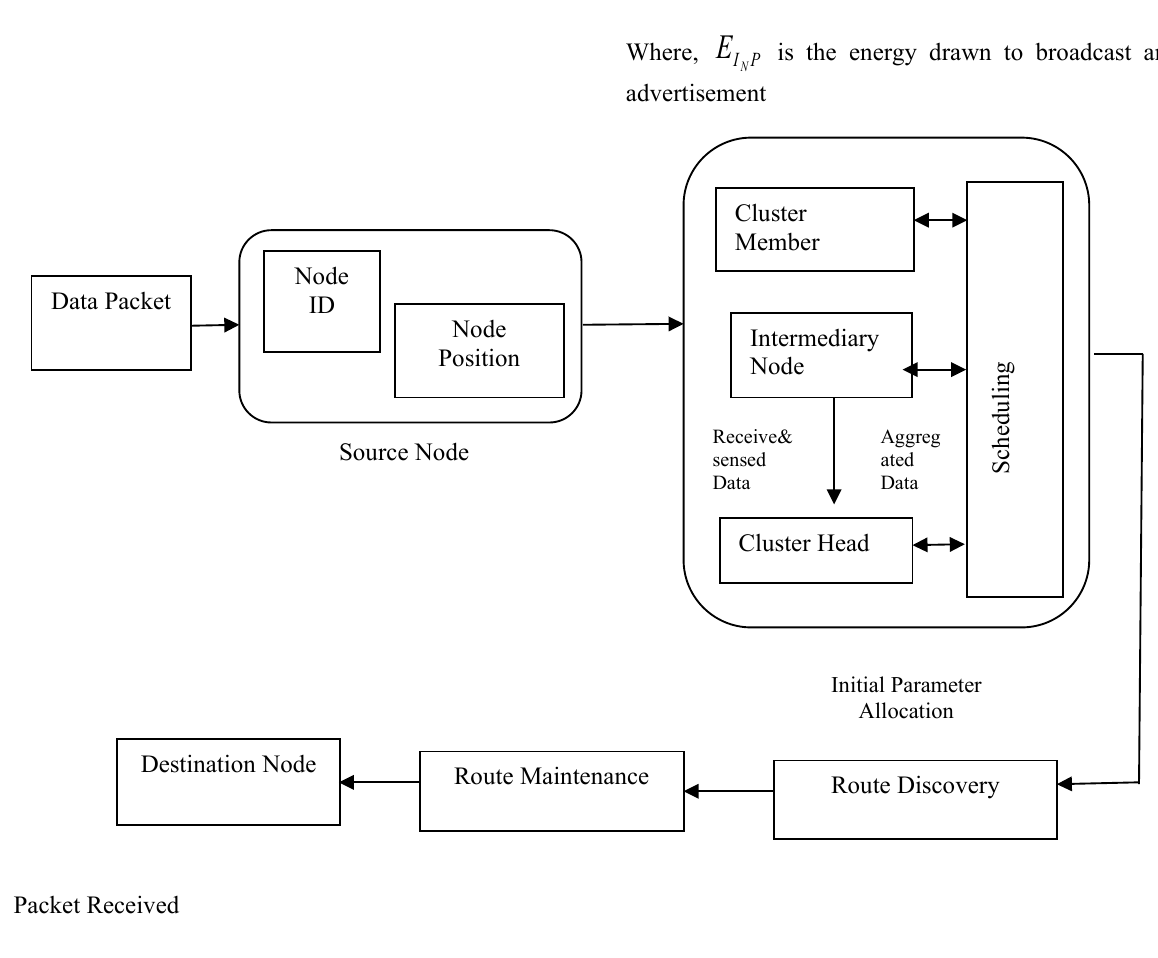
Figure 2. Block Diagram for